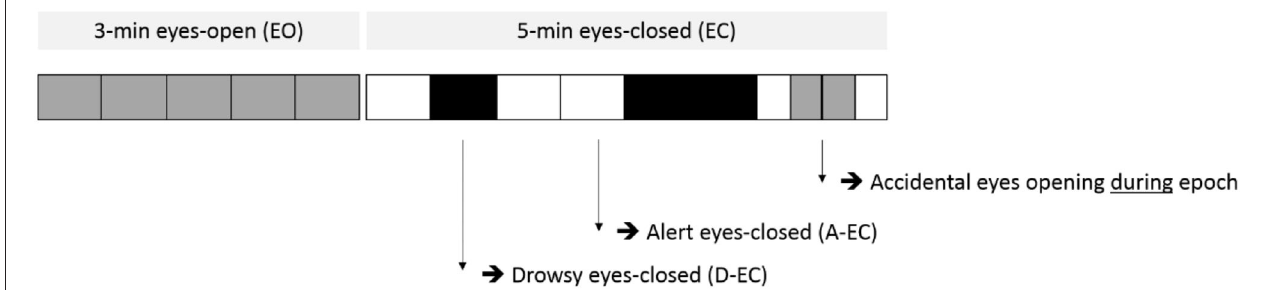
FIGURE 1 | Example of the scoring of epochs (vertical lines mark the start/end of different epochs, each epoch is 13.1072s) for both the eyes-open (EO) part (part one, light gray) and the eyes-closed (EC) part (part two, white and black) of the recording protocol. Epochs in part two were scored for the presence of alert eyes-closed (A-EC, white) or drowsy eyes-closed (D-EC, black) epochs. Note the accidental opening of the eyes during the eyes-closed